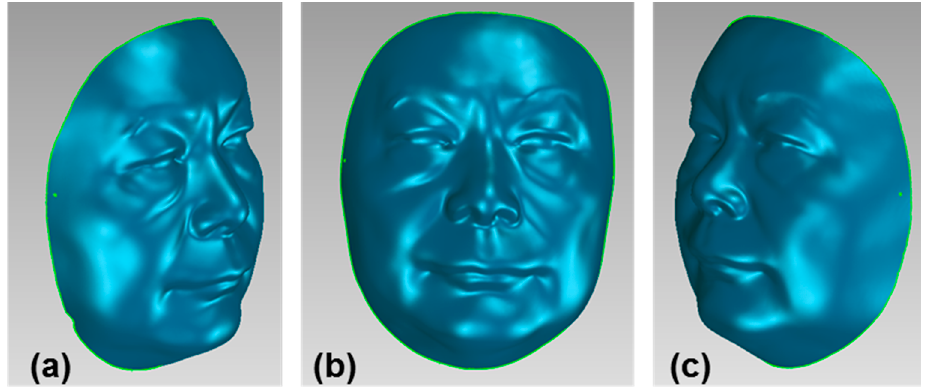
Figure 9. Pairs of infrared image acquired by our device.